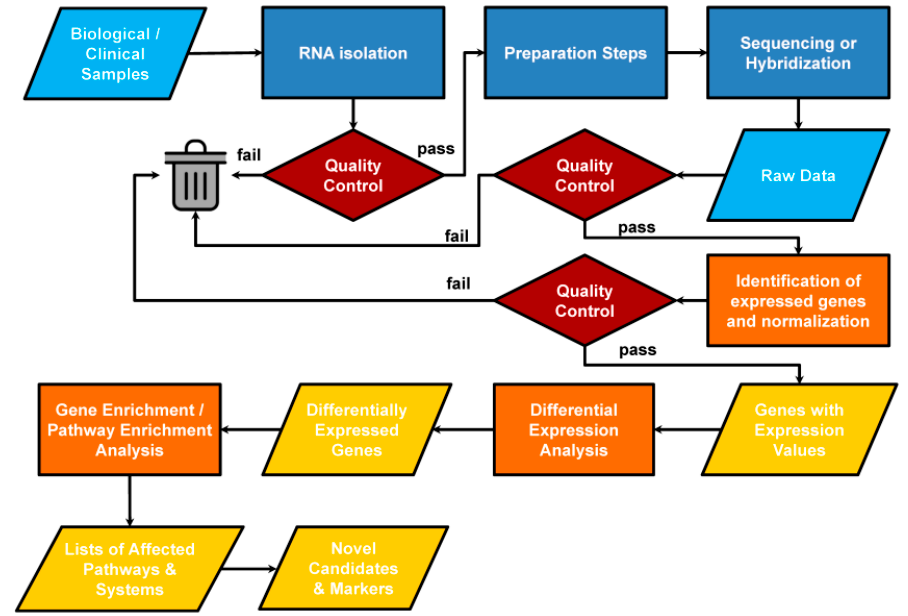
Figure 5. Generalized pipeline for a high-throughput microarray or RNA-seq transcriptomics study.